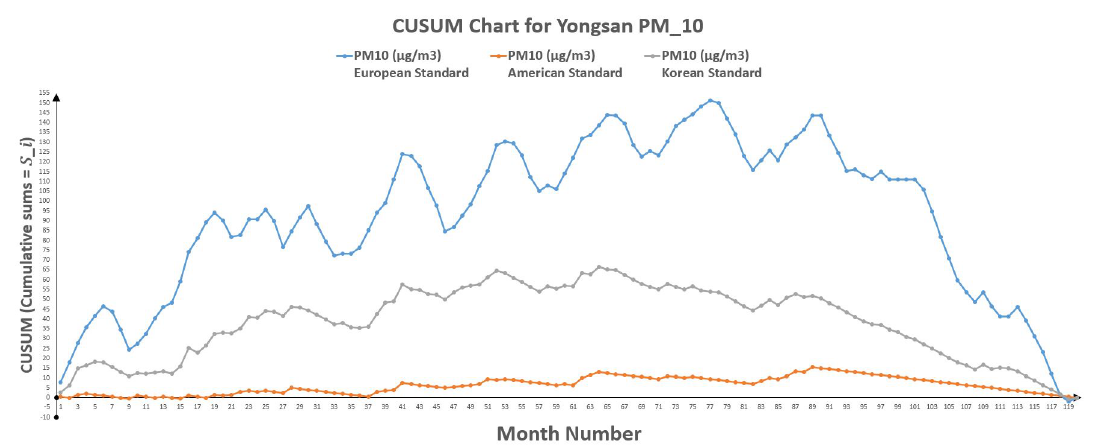
Figure 9. CUSUM chart for Yongsan PM 10